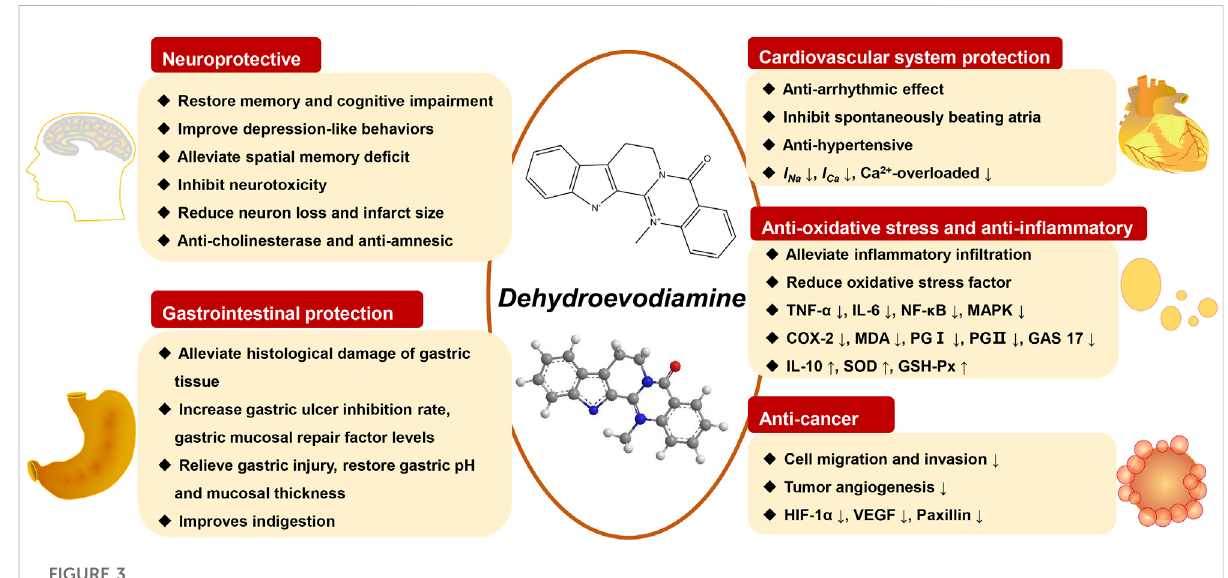
FIGURE 3 The pharmacological properties of DHE and its potential biological